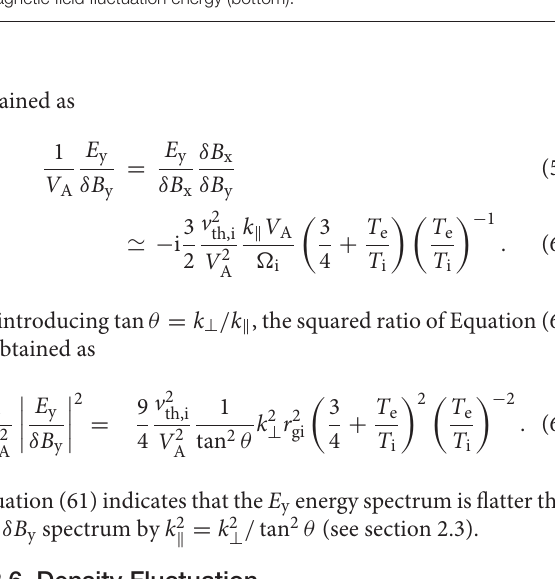
FIGURE 6 | Ratios of the electric field energy to the total magnetic field fluctuation energy (top) and parallel magnetic field energy relative to the total magnetic field fluctuation energy